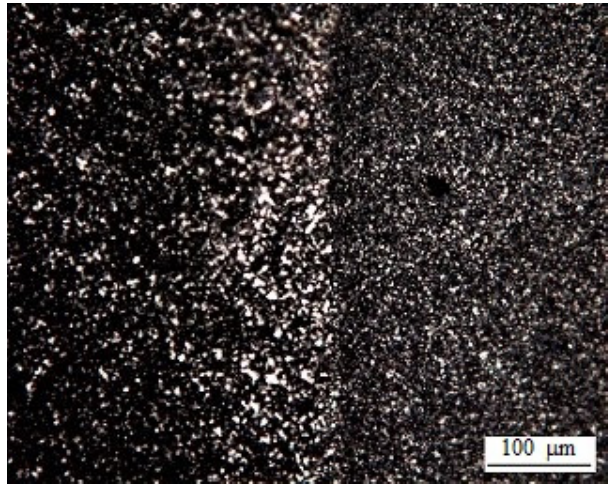
Figure 11. Optical microphotograph of the transition zone of the LLDPE–HDPE-1 system obtained in polarized light.